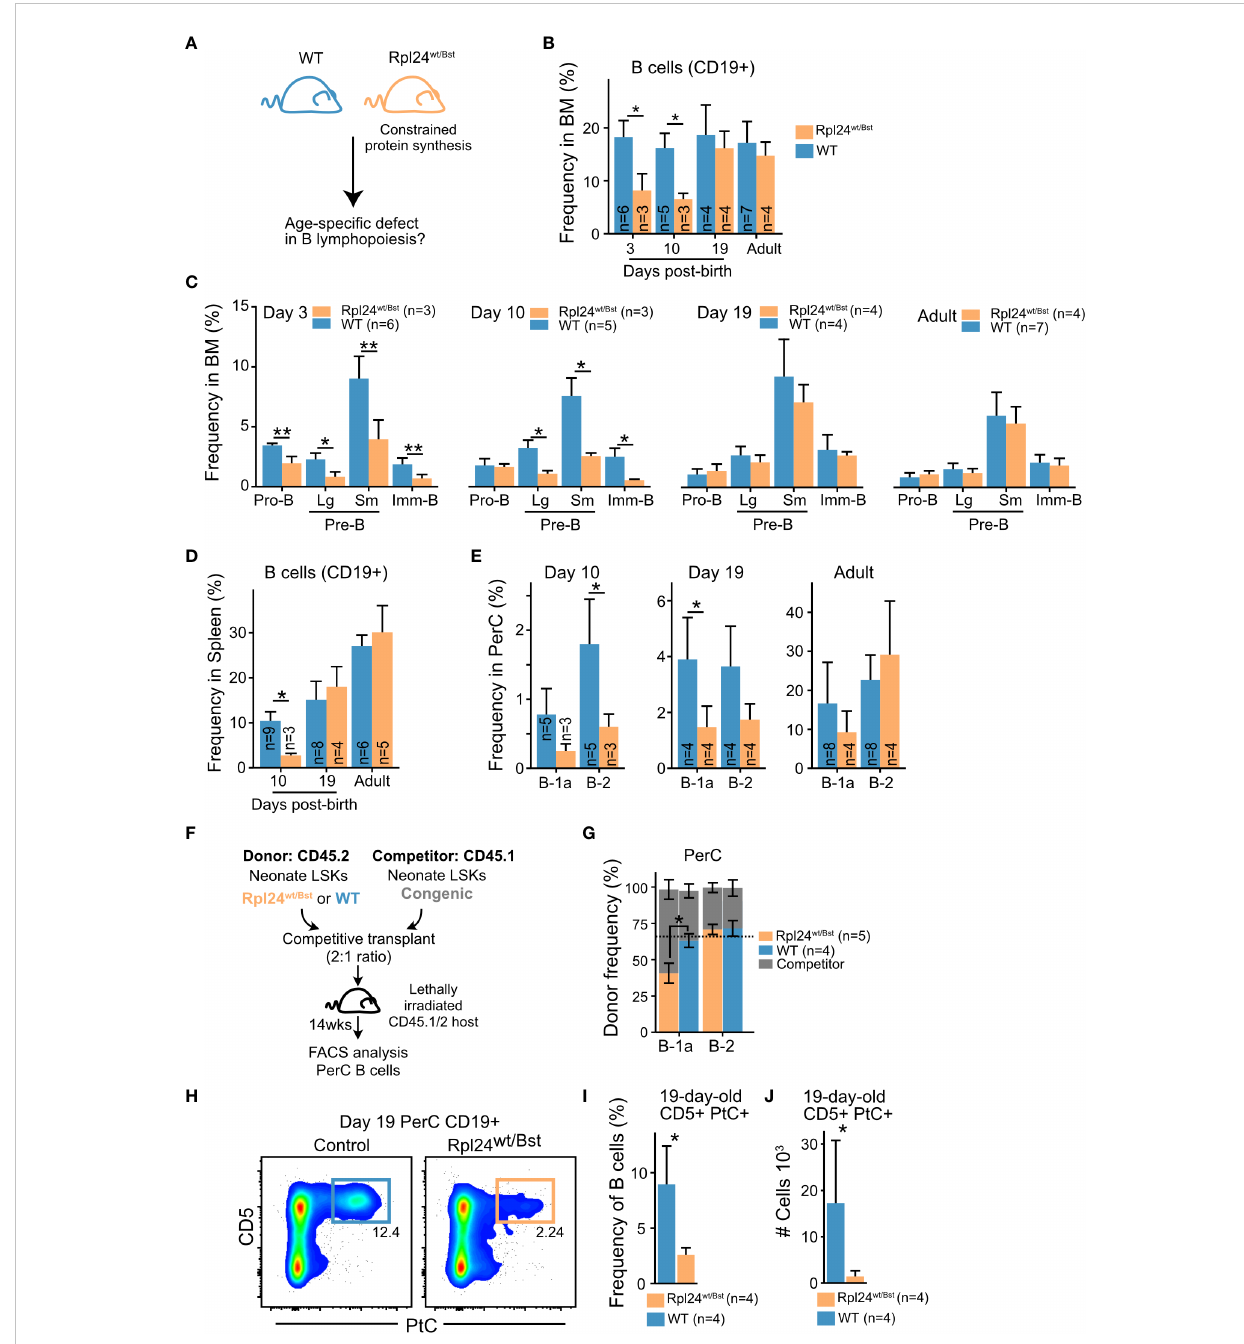
FIGURE 5 Neonatal B cell development relies on enhanced protein synthesis (A) Rpl24 wt/Bst and wildtype littermates were analyzed by FACS at different ages for phenotypic differences during BM B cell development. (B) Frequency of CD19+ B cells out of total BM cells at the indicated ages. (C) BM B cell precursor subset frequencies at the indicated ages presented as percent of total BM cells. (D) Frequency of splenic CD19+ B cells out of total splenocytes at the indicated ages. (E) Mature PerC B-1a and B-2 cell frequencies out of total PerC cells at the indicated ages. (F) Experimental overview for assessment of cell intrinsic defect of the Rpl24 wt/Bst mutation. Lineage – , Sca1+, cKit+ (LSK) hematopoietic stem and progenitor cells (HSPCs) from 10-day-old donor and competitor mice of the indicated genotypes were sorted and transplanted into lethally irradiated recipients. 13-14 weeks later, the steady state donor and competitor derived mature PerC B cells were analyzed to assess B-1a and B-2 cell output. (G) CD19+ PerC B cells of the indicated subsets were compared for donor versus competitor contribution. The expected frequency based on donor: competitor ratio is indicated by the dashed line. (H) Representative FACS plots showing the frequency of CD5+ PtC-liposome reactive B cells in 19-day old littermates. (I) CD5+PtC+ frequency out of PerC CD19+ B cells in 19-day-old mice. (J) Absolute number of CD5+PtC+ B cells in PerC in 19-day-old mice. Wilcox test was used to calculate p-values. *p<0.05, **p<0.01. Bars show mean ± standard